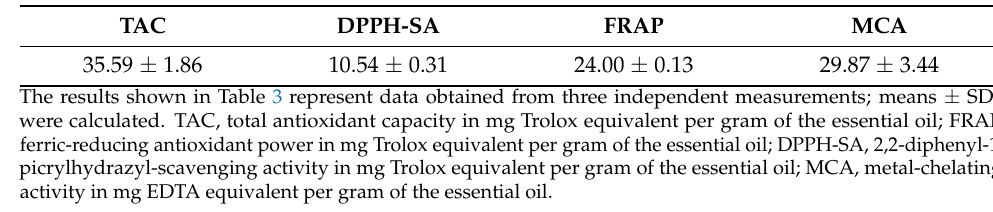
Table 3. Antioxidant activity of A. absinthium essential